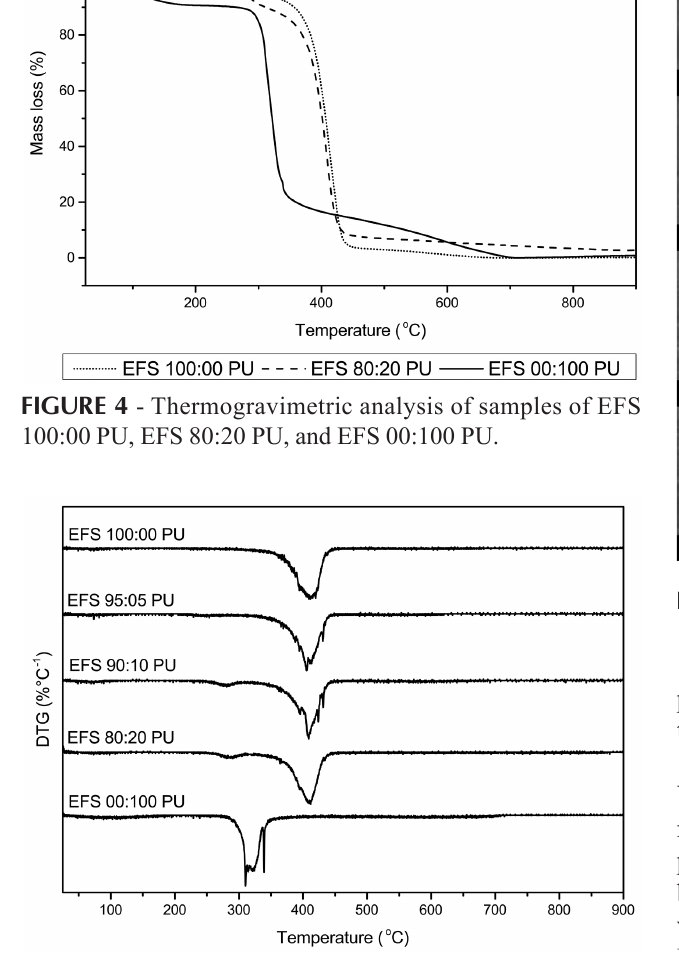
FIGURE 5 - First-derivative TGA of the films with various concentrations.